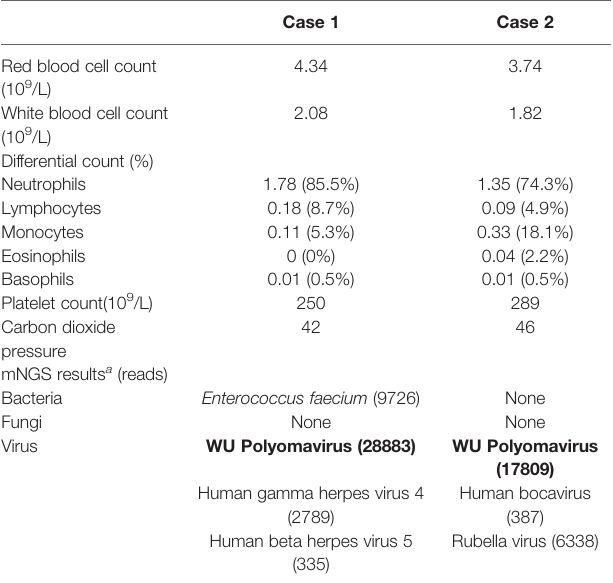
Table 1 . Upon admission, cotrimoxazole and methylprednisolone were given immediately to control infection and relieve in fl ammation. Fourteen days later, fungal hyphae were found in the respiratory tract, and voriconazole was added. On Day 87, his dyspnoea increased, and mechanical ventilation was given. On the 98th day of admission, his transcutaneous oxygen saturation, heart rate, and blood pressure dropped severely, with spontaneous breathing and aorta pulsates disappearing. He fi nally died due to severe acute respiratory distress syndrome that developed from pneumonia.